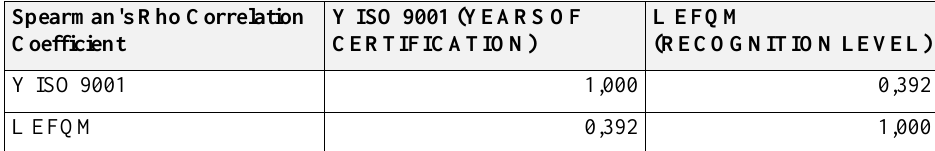
Table 6 – SPSS Output results for Spearman Correlation coefficient between variables Y ISO 9001 and L